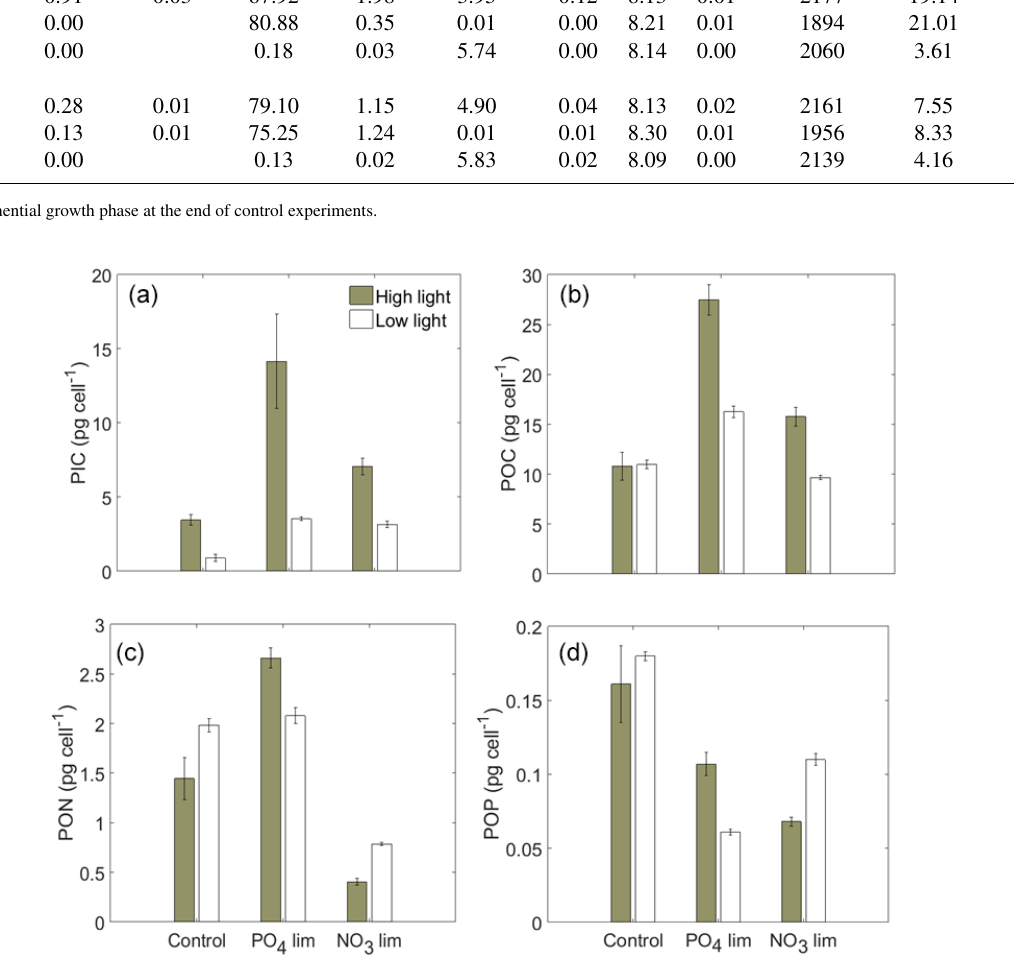
Figure 2. Cellular PIC (a) , POC (b) , PON (c) , POP (d)